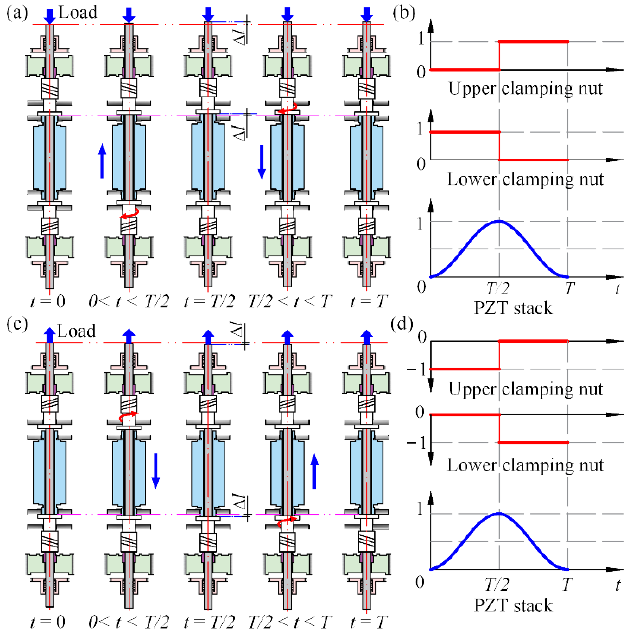
Figure 2. Operation principle of the actuator. ( a ) Operation in forward motion, ( b ) motion state of the components in forward motion, ( c ) operation in backward motion, ( d ) motion state of the components in backward motion.